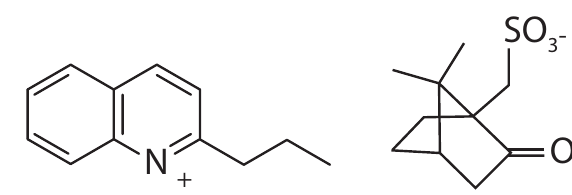
Fig. 1. – Chemical structure of the 2-n-propylquinoline camphor- sulfonic salt.